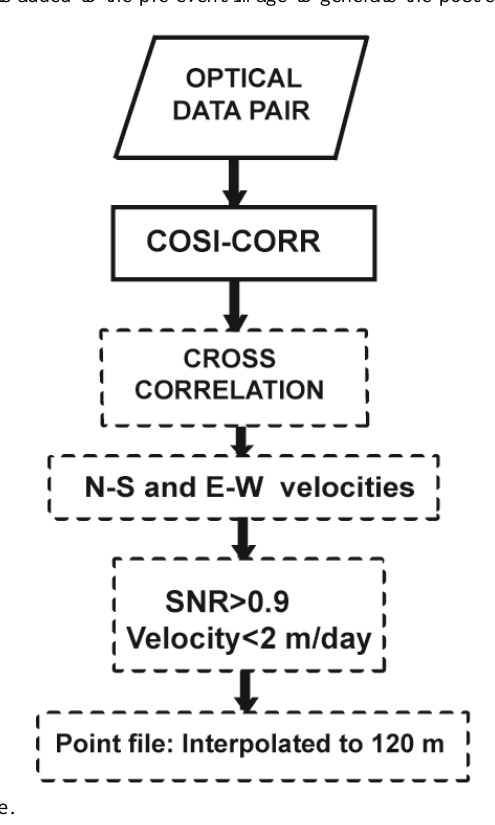
Figure 2: Methodology